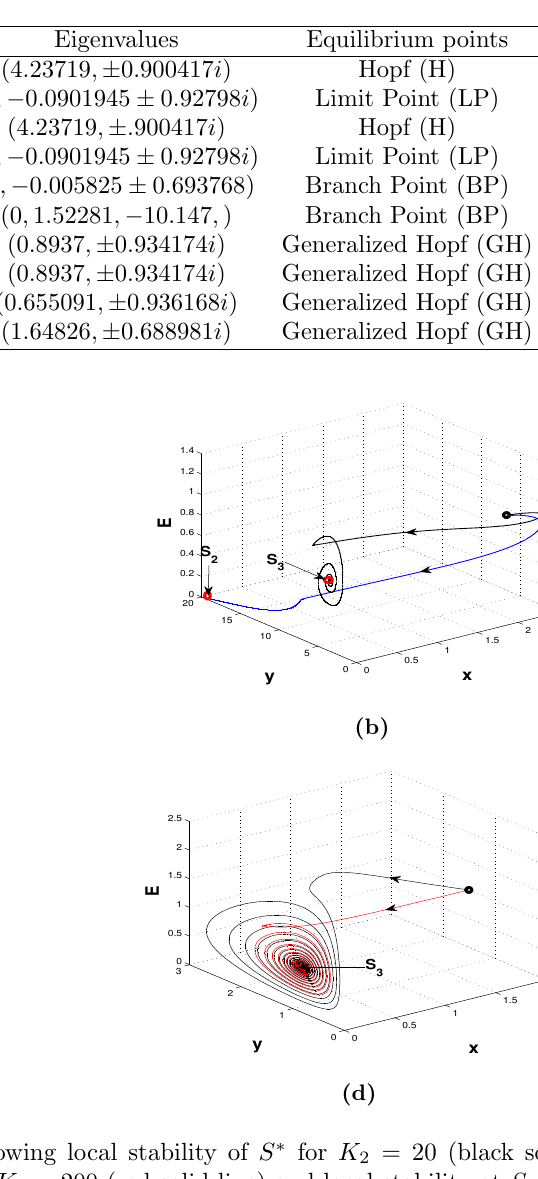
Table 2. Natures of equilibrium points.